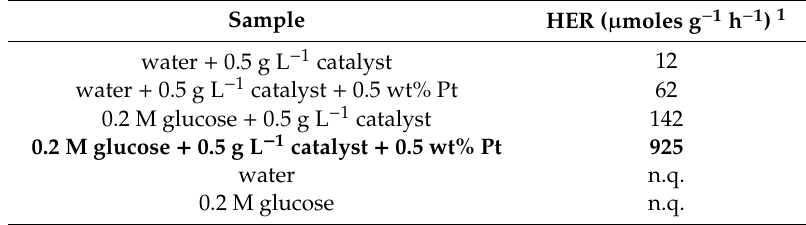
Table 3. Key experiments for evaluating the photocatalytic system based on 33% DMASnBr 3 / g-C 3 N 4 (simulated solar